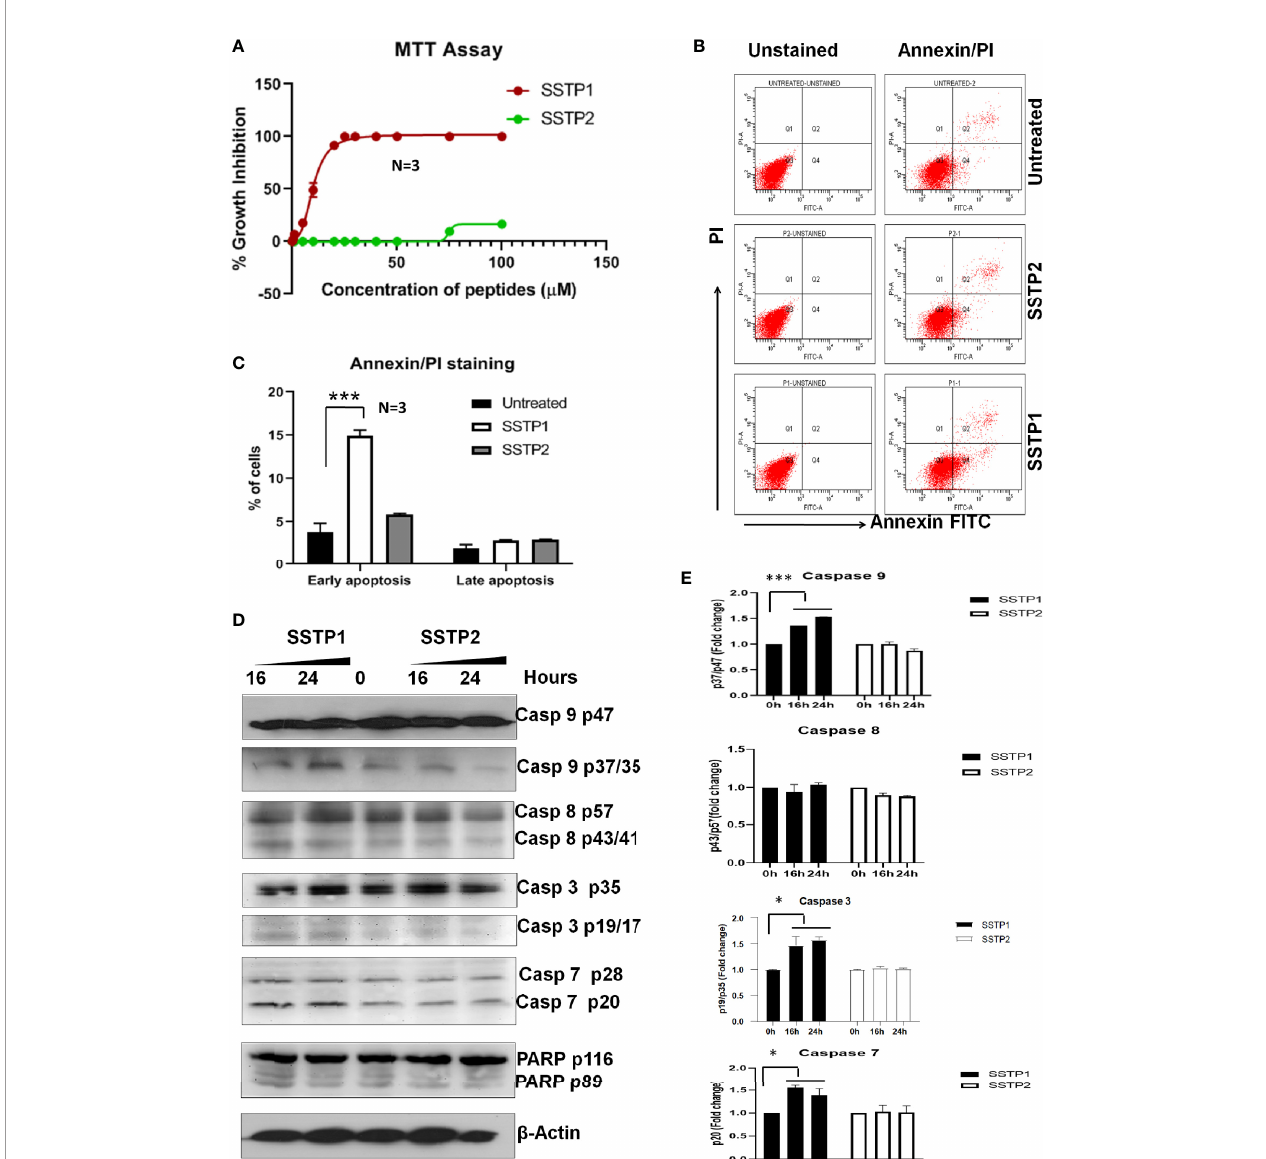
FIGURE 1 | SSTP1 induces apoptosis in oral cancer cells (A) HSC-4 cells were treated with peptides SSTP1 and SSTP2 at different concentrations in 0.5% DMEM for 48 h, and MTT assay was performed to calculate % growth inhibition. The graph was plotted using GraphPad Prism8.2.1using non-linear four parameter curve fi t. The error bars indicate SEM of three biological replicates (B) HSC-4 cells were treated with 10 m M SSTP1 and SSTP2 for 22h and FACS analysis was performed after annexin/PI staining. (C) The quanti fi ed populations are represented in the graph. The error bars indicate standard deviation of triplicates. (D) The HSC-4 cells treated with 10 m M SSTP1 or SSTP2 for indicated time intervals were used for western blot analyses (E) Densitometric analysis was done for the bands, and fold change based on 0min was calculated. The error bars indicate standard deviation of biological duplicates. *p < .05, ***p <